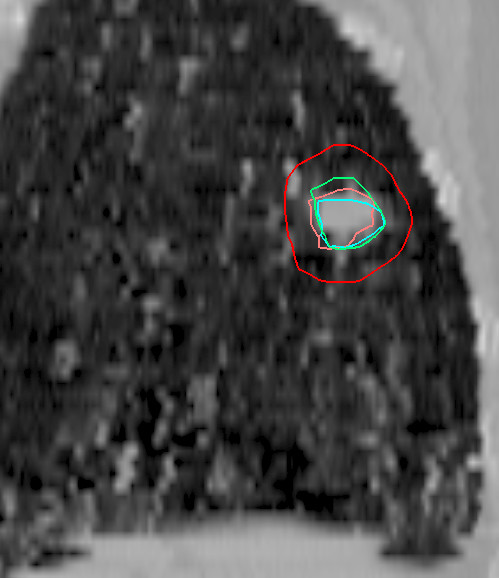
Image fusion of three dynamic CT scans in a reconstructed sagittal plane for determining target position (CTV) during respiration. (Green line: normal inhalation, pink line: naturally contracted position of the chest, blue line: normal exhalation, red line: PTV.) Tilting the tumor in x and y axes during respiration facilitates the phase-specific display of the CTVs.